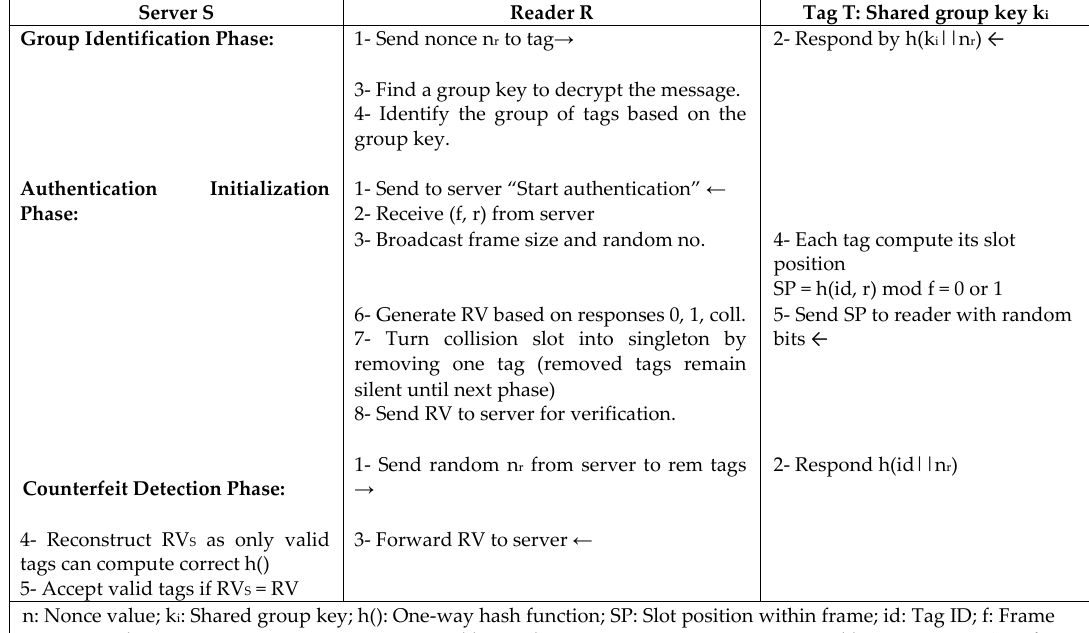
Figure 16. Batch Authentication Protocol based on Frame Slotted Aloha (FTest) by Rahman and